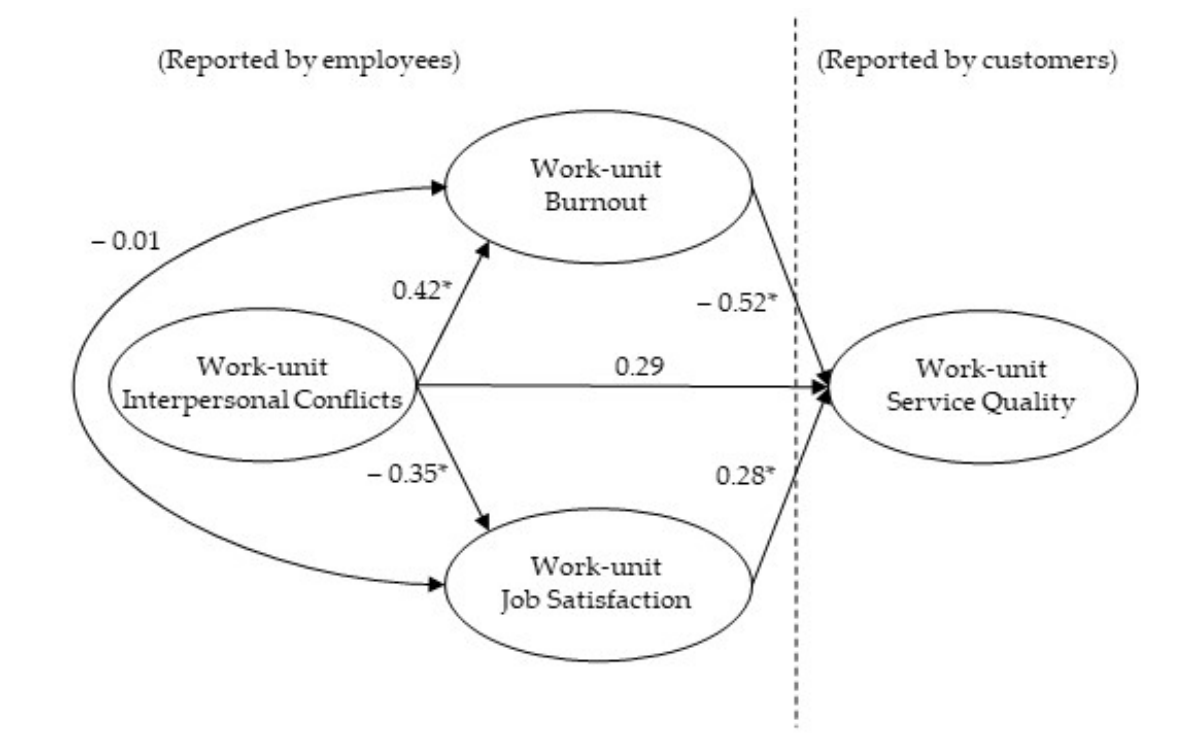
Figure 1. Partial mediation model. * p < 0.01. Standardized coefficients.